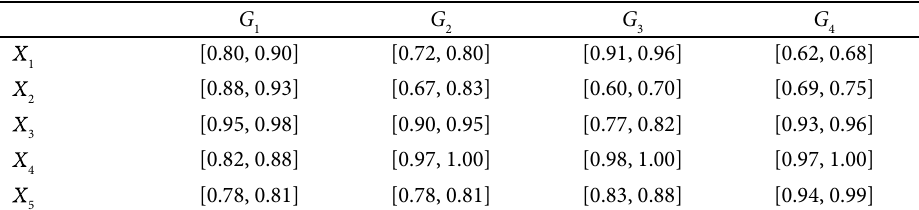
Table 1. Decision matrix 1 A